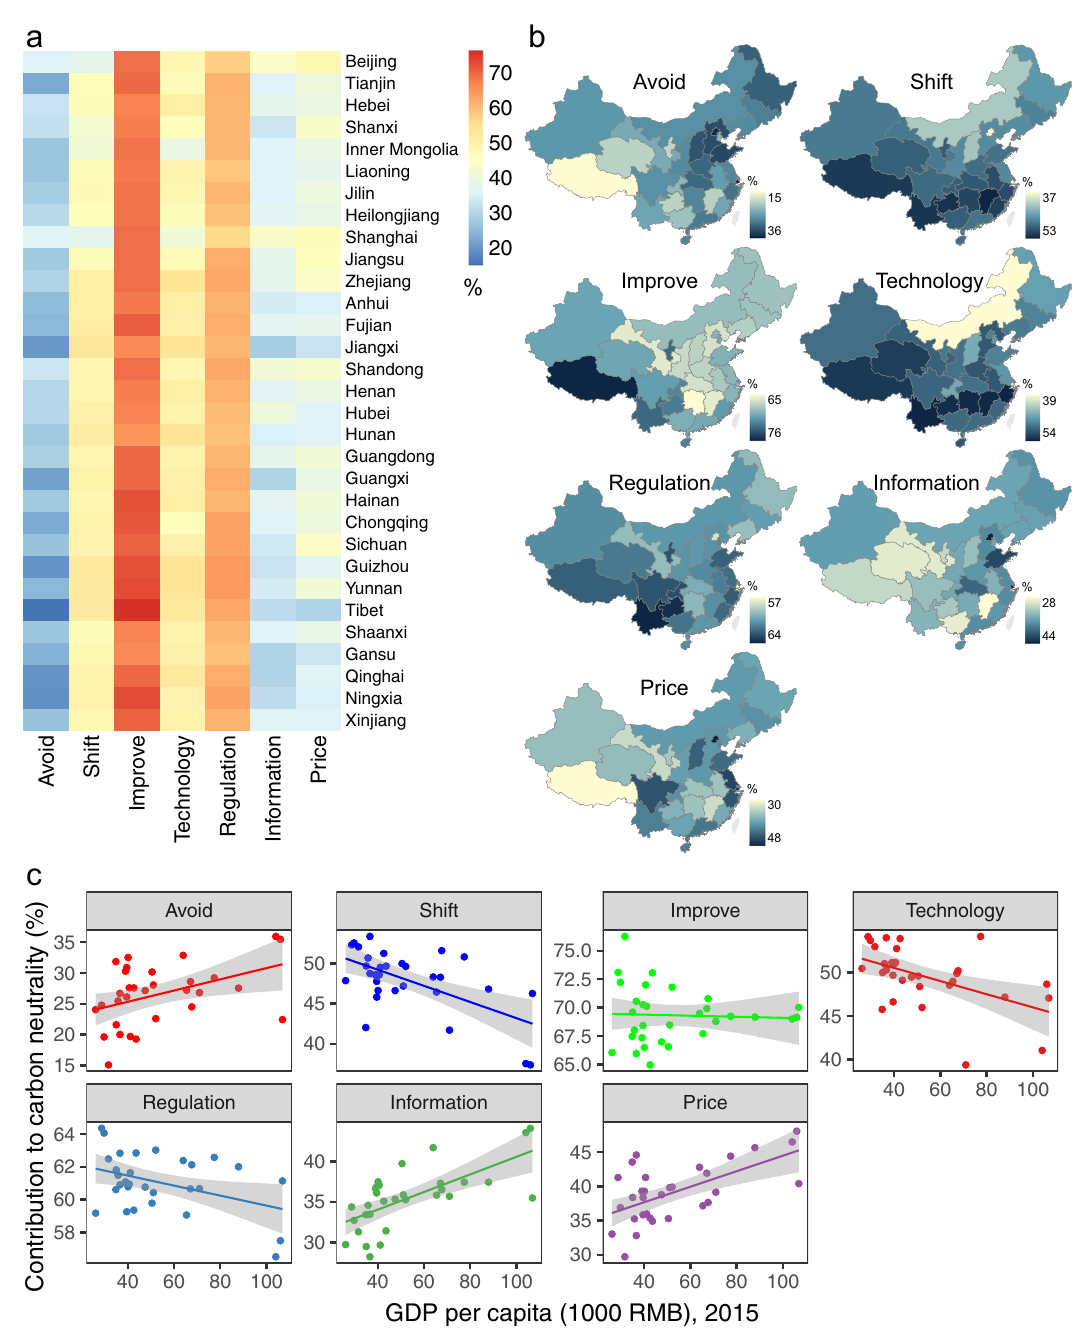
Fig. 5 Regional differentiation of emission reductions. a The heatmap indicates the contribution to the carbon neutrality target in 31 provinces under seven strategies and instruments. The horizontal axis is the three strategies and four instruments, while the vertical axis is the 31 provinces. b The geographical information system (GIS) map shows the geographic distributions of emission reduction potentials under seven strategies and instruments in 31 provinces. c The scatter diagram shows the correlation between GDP per capita and the contribution to carbon neutrality due to different strategies and instruments. The shaded areas in c show 95% con fi dence